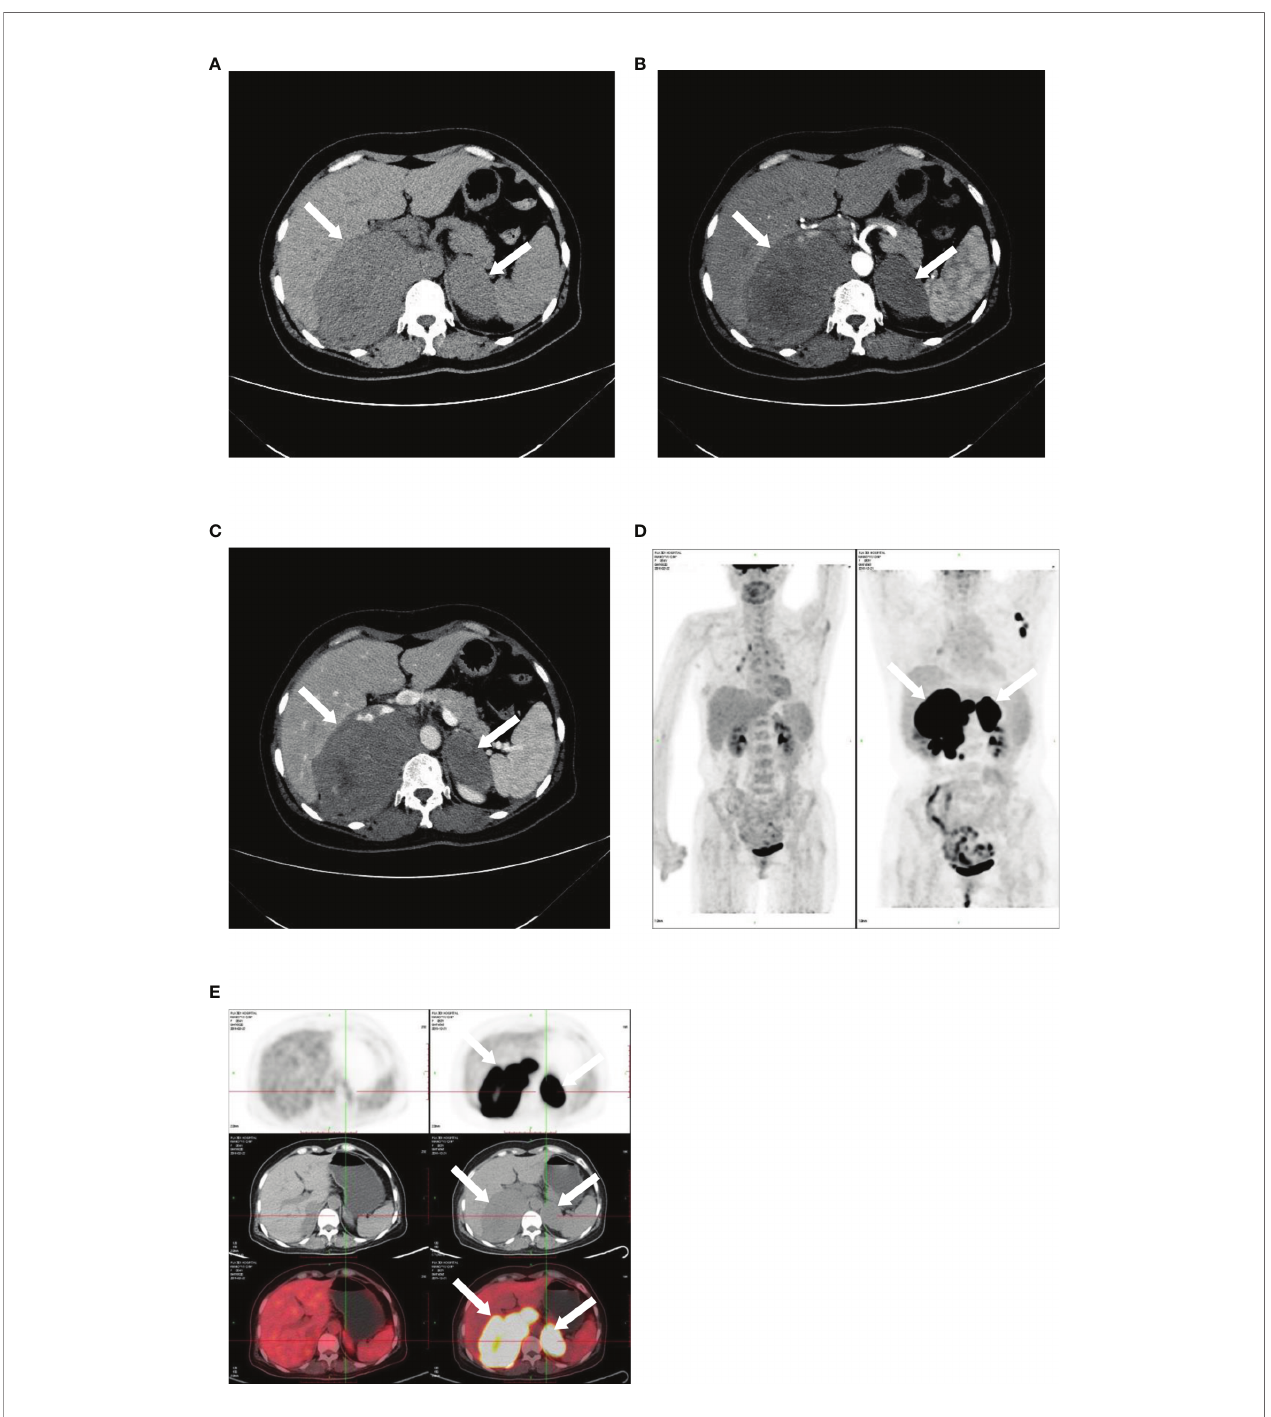
FIGURE 4 | Imaging of bilateral primary adrenal lymphoma. CT and PET images illustrating bilateral primary adrenal lymphoma. CT scans: (A) , non-contrast phase; (B) , arterial phase; (C) , venous phase. 18F-FDG PET-CT: (D, E)